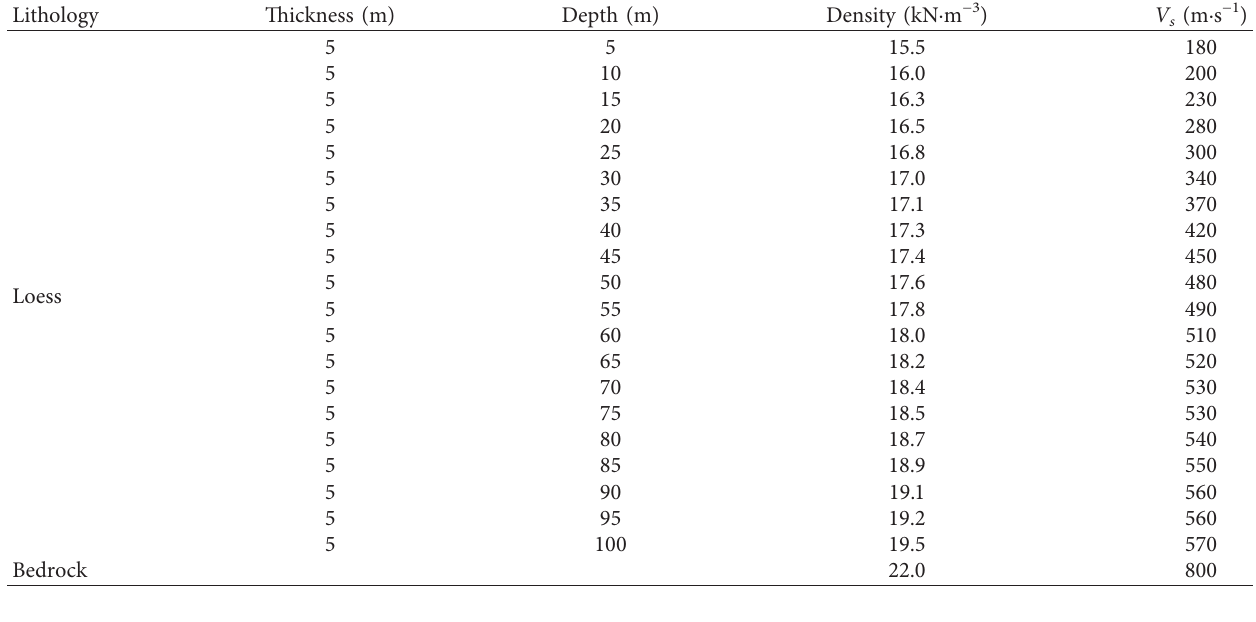
Table 2: Soil parameters of one-dimensional model.